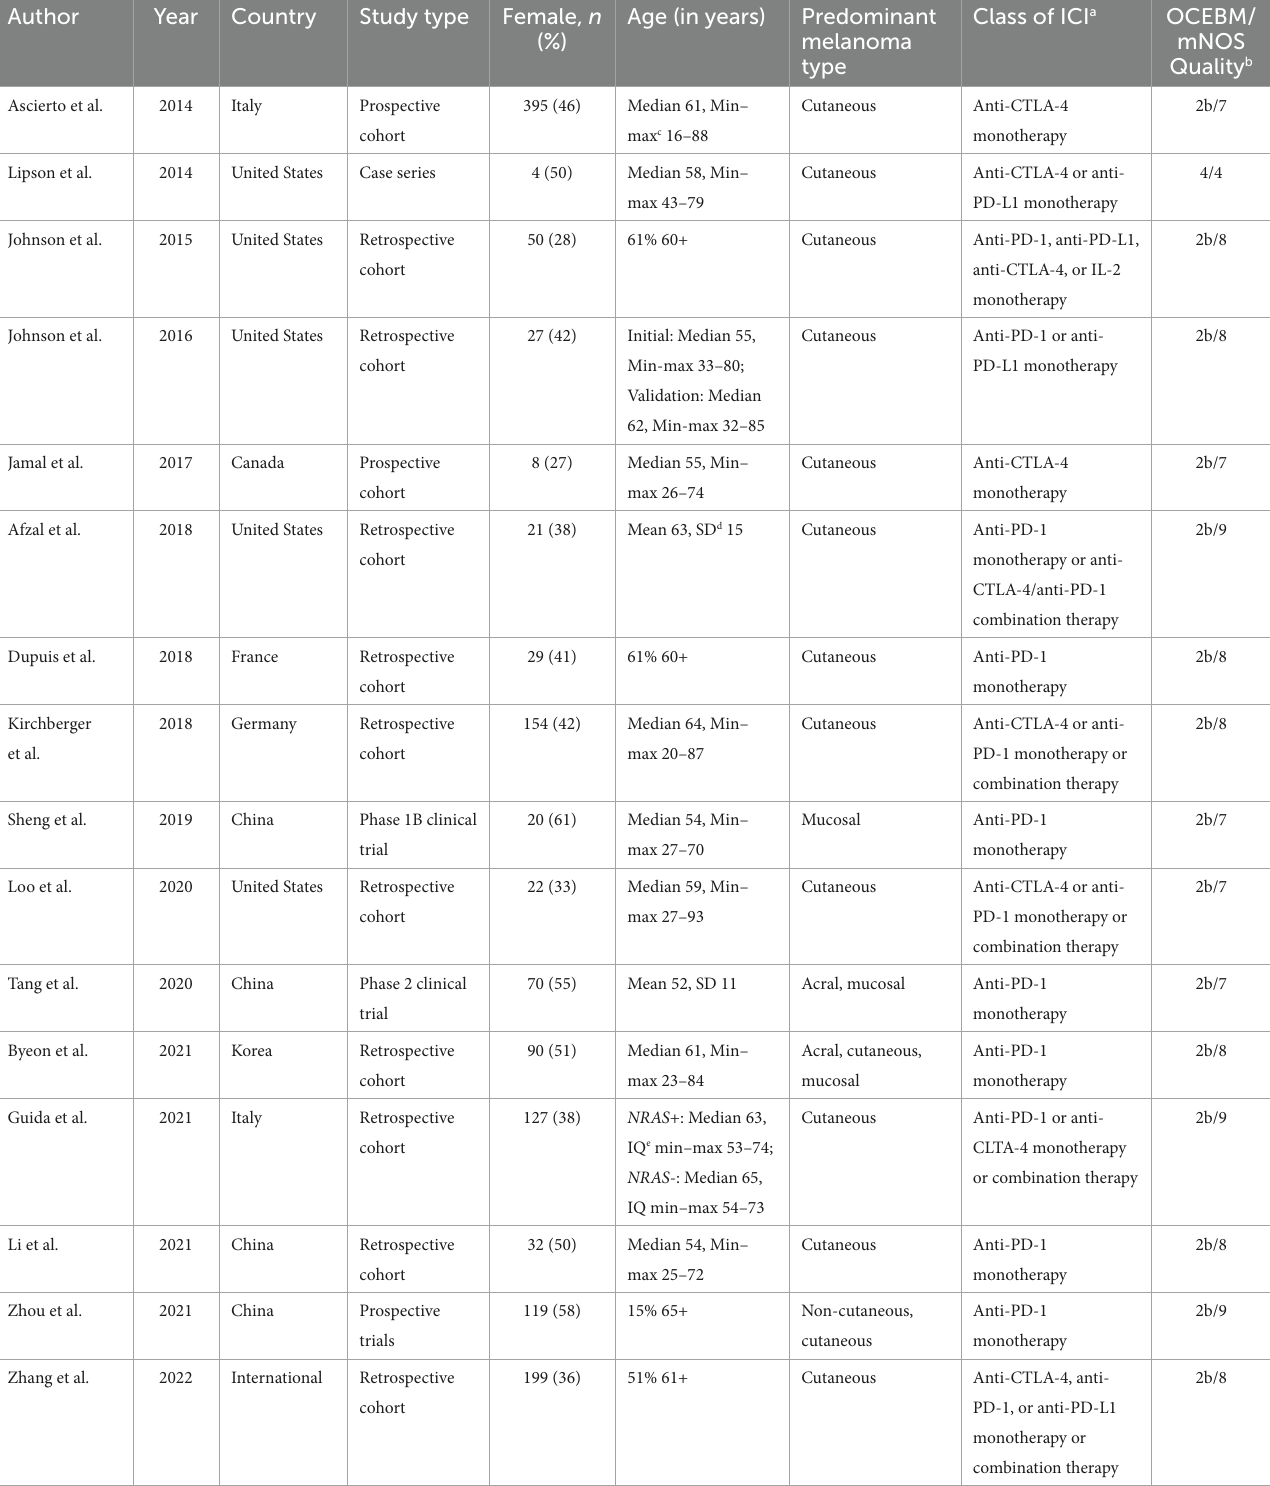
TABLE 1 Summary data and quality